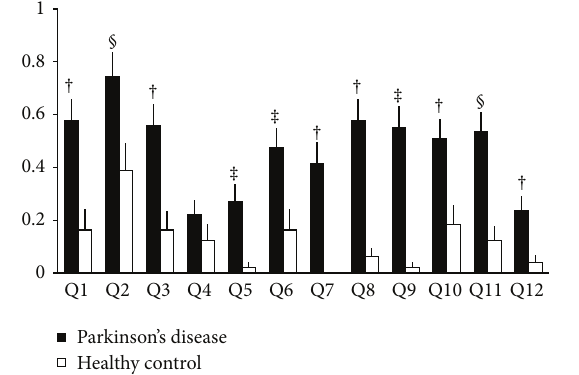
Figure 1: Results for each item of the frequency scale for symptoms of gastroesophageal reflux disease. All values are shown as means and standard errors. Each symbol indicates the 𝑃 value: § 𝑃 < 0.05 , ‡ 𝑃 < 0.01 , and † 𝑃 < 0.001 .